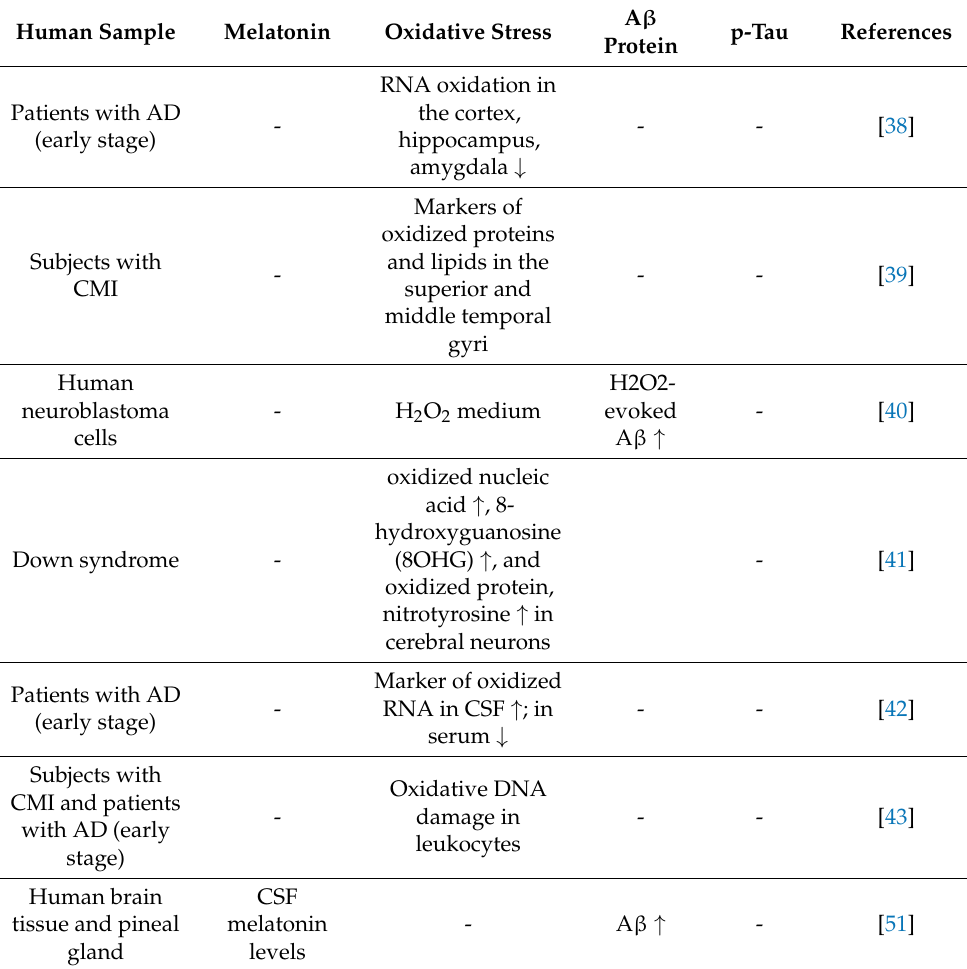
Table 2. Clinical data considering the link between oxidative stress, beta-amyloid peptide, and p-Tau